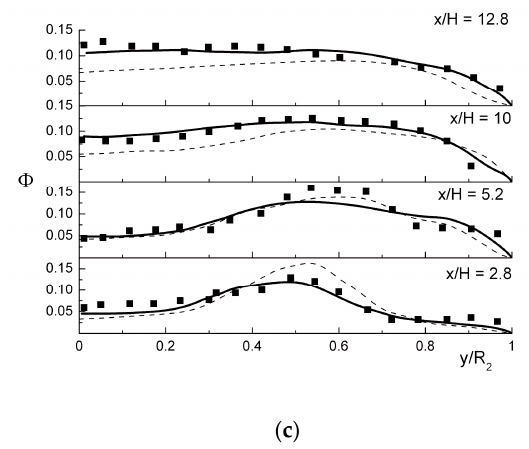
Figure 9. The profiles of mean axial fluid velocity ( a ), fluid phase axial velocity fluctuations ( b ) and gas volume fraction ( c ) across the radial coordinate in bubbly isothermal upward flow in the pipe with sudden expansion. 1 —measured results of [15], 2 —LES data [10], 2 —authors’ predictions. Re H = 1.11 × 10 5 , U m 1 = 1.78 m/s, d 1 = 2 mm, 2 R 1 = 50 mm, H = 25 mm, 2 R 2 = 100 mm, ER = ( R 2 / R 1 ) 2 = 4, T 1 = T b 1 = 300 K.